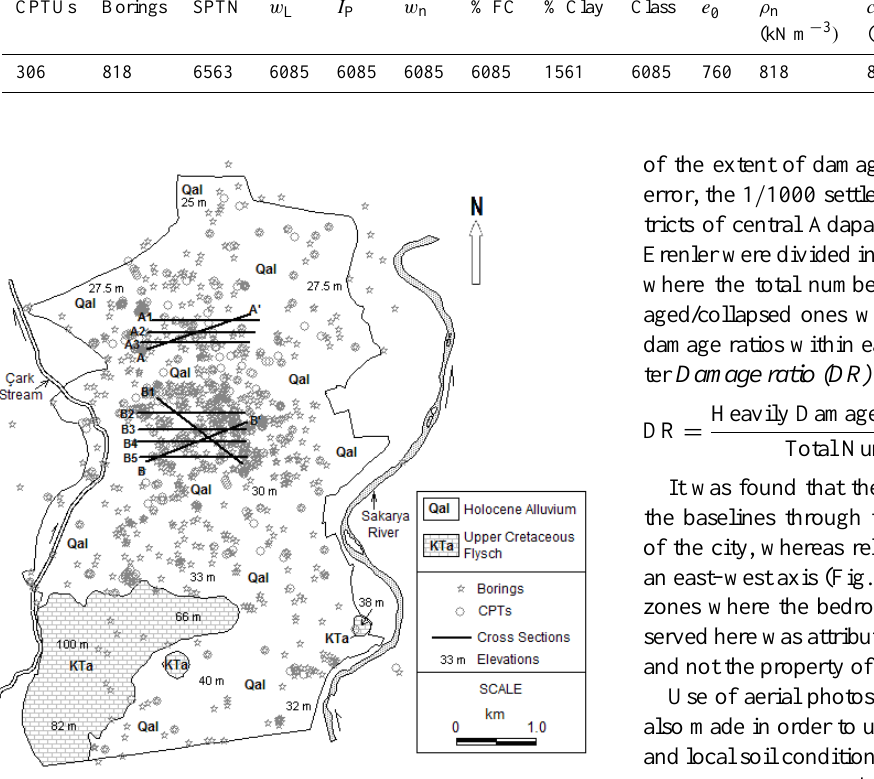
Fig. 2. The area of study in Adapazarı and the points of drilling and